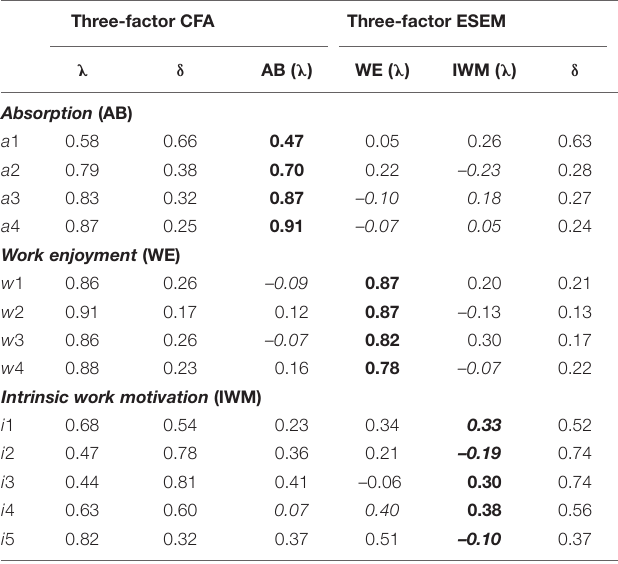
TABLE 3 | Standardized parameter estimates for three-factor CFA (Model 6) and three-factor ESEM (Model 7) models.